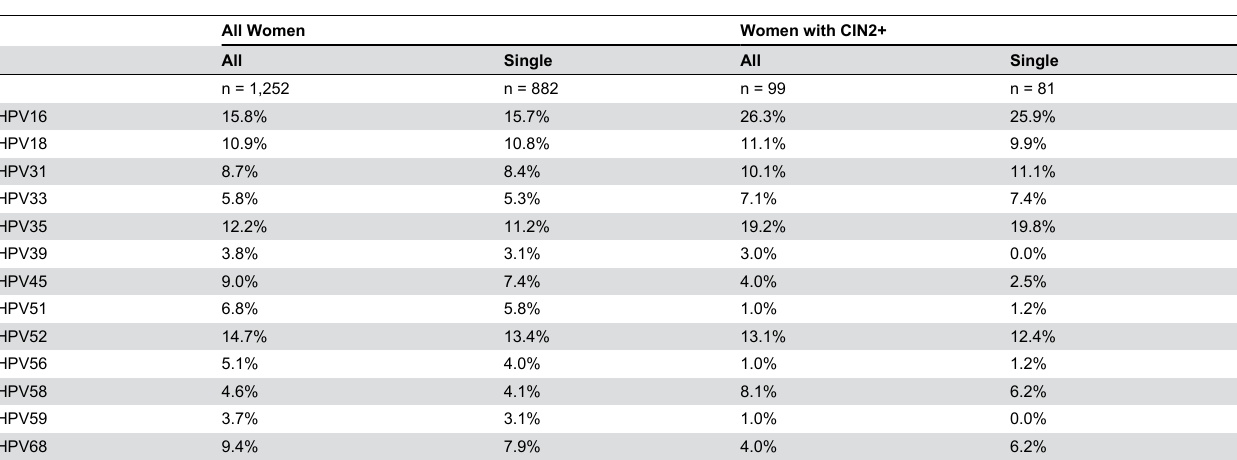
Table 3. Individual carcinogenic HPV genotypes.